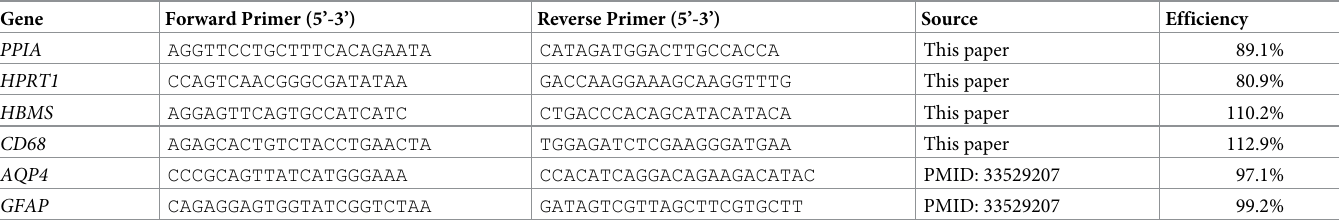
Table 2. Primer sequences and amplification efficiencies for